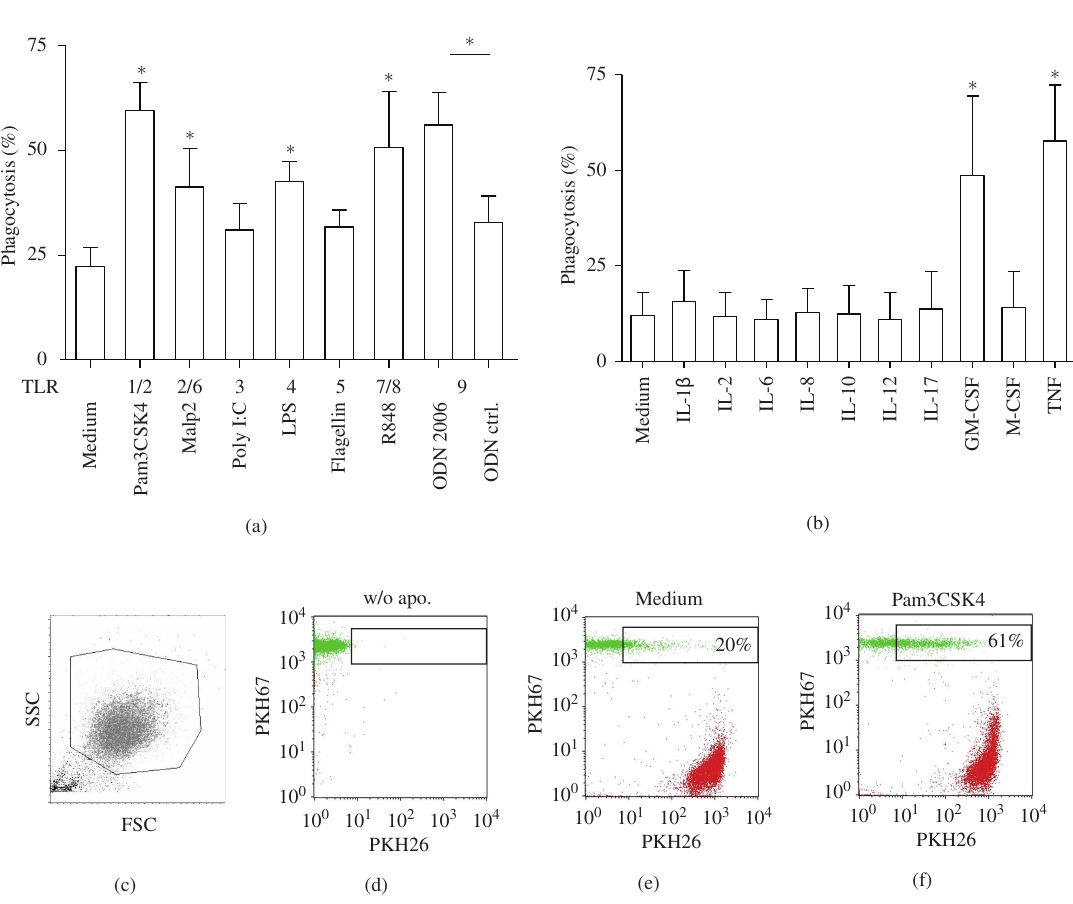
FIGURE 1: Phagocytosis of apoptotic neutrophils by purified human neutrophil granulocytes. 1 × 10 5 PKH67 stained viable neutrophils were preincubated with the indicated stimuli for 30 min and, subsequently, 4 × 10 5 PKH26 stained apoptotic neutrophils were added. Phagocytosis was assessed by flow cytometry after 90 min. (a) Effect of TLR-ligands on the phagocytosis rate. (b) Effect of various cytokines on the phagocytosis rate. Data show mean + SD from 3 independent experiments, ∗ : P < 0 . 05 . (c)– (f) Representative dot-plots for the quantitative assessment of ingestion of apoptotic cells by purified neutrophils by using flow cytometry. (c) FSC/SSC gating of neutrophils. (d) Negative control: PKH67- labeled (green) fresh neutrophils without apoptotic cells. (e) PKH67-labeled (green) fresh neutrophils after coincubation with PKH26-labeled (red) apoptotic neutrophils in medium alone. (f) Pam3CSK4-treated PKH67-labeled (green) fresh neutrophils after coincubation with PKH26-labeled (red) apoptotic